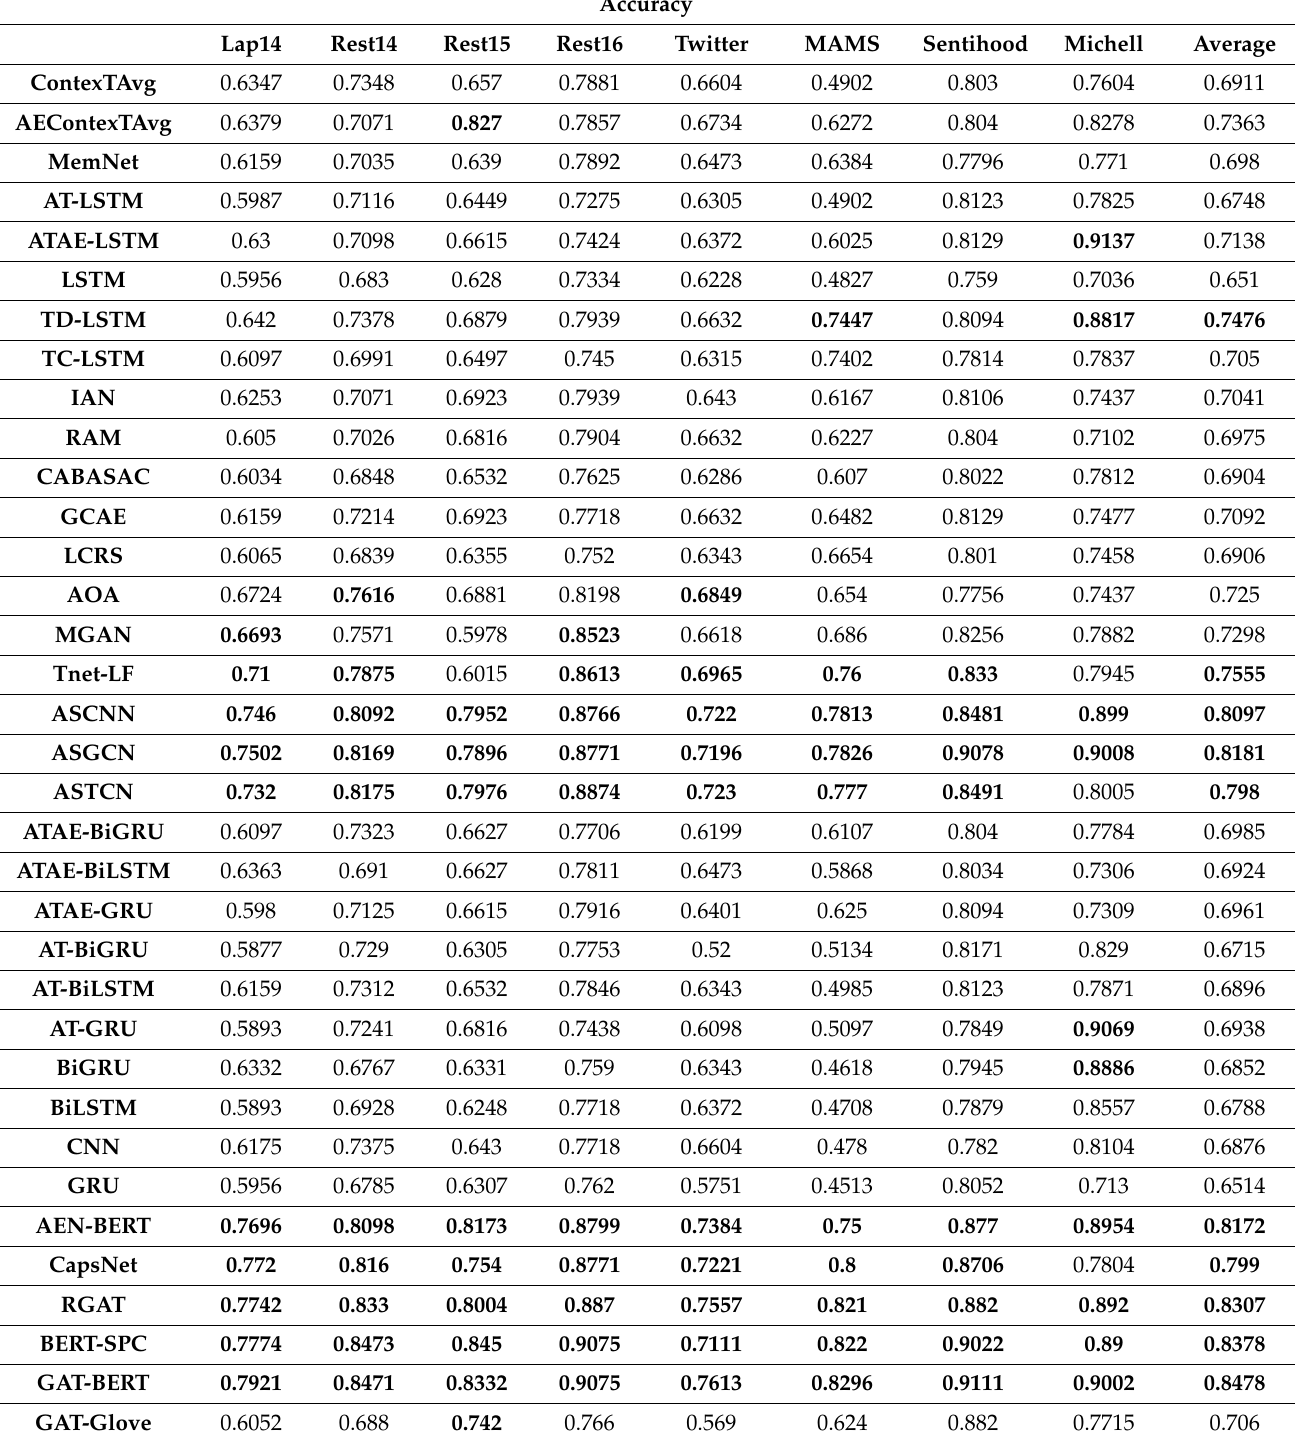
Table 3. Experimental results obtained for Accuracy in our